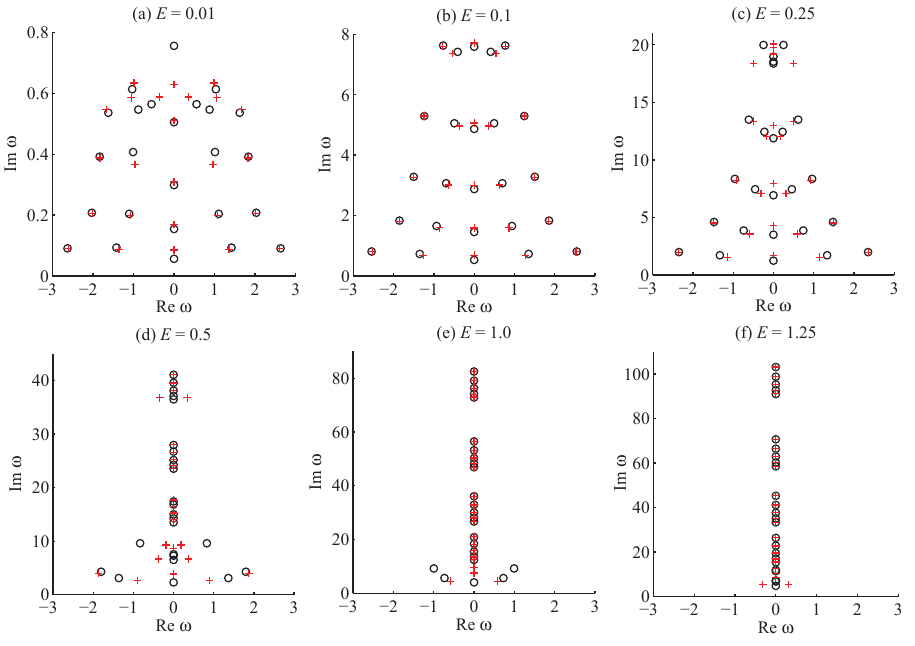
( 0 ) ( 0 ) or (+) ω of the 55 55 ( 0 ) ( 0 ) E increases from ( a – f ), more and and M 55 . Notice that as 55